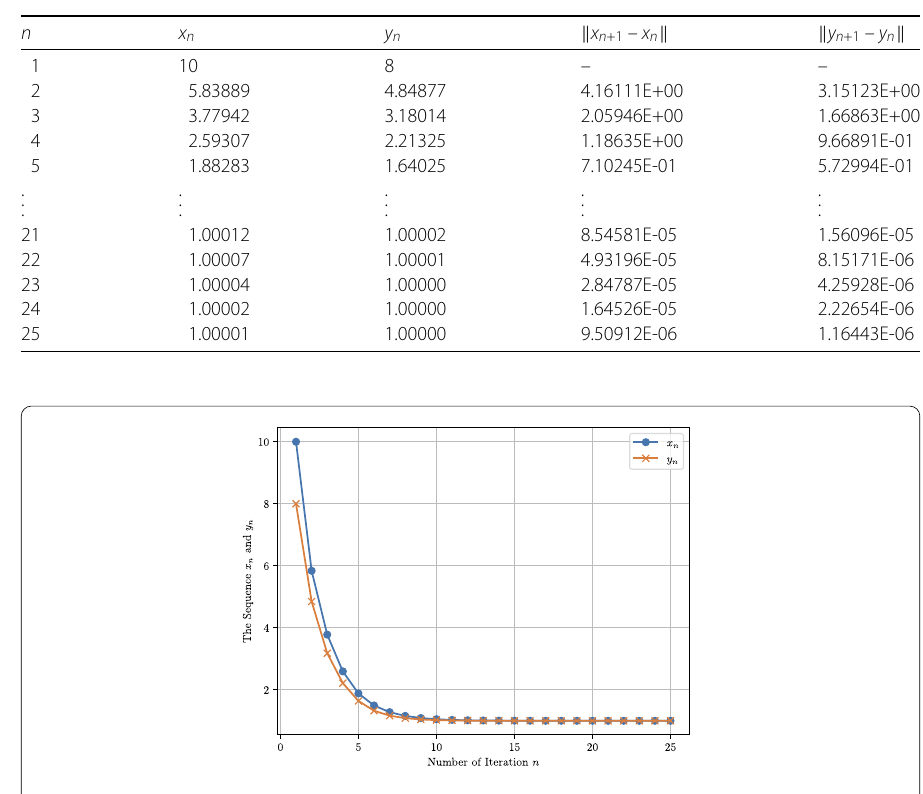
Table 1 The values of { x n } and { y n } with initial values x 1 = 10, y 1 = 8 in Example 5.1